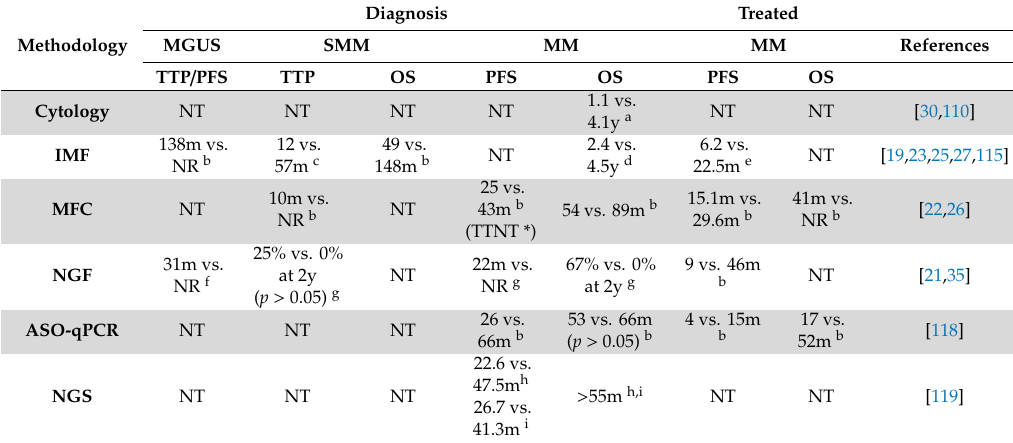
Table 3. Prognostic impact of circulating tumor plasma cells on newly diagnosed and treated plasma cell neoplasms patients as assessed by distinct